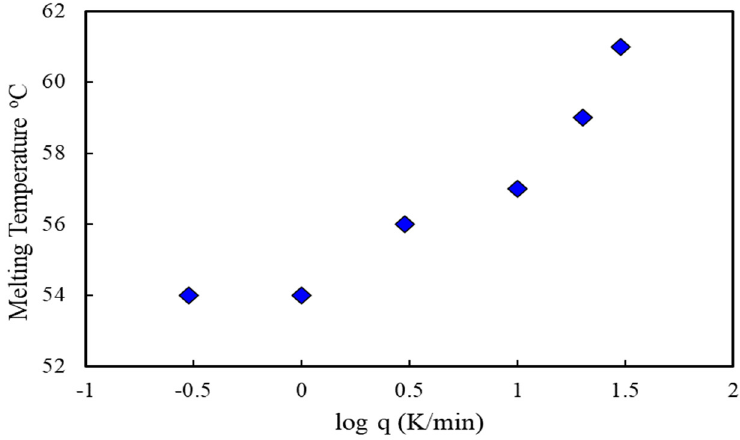
Figure 11. Cooling rate dependence on melting temperature for 10 wt.% PCL nanofibers.